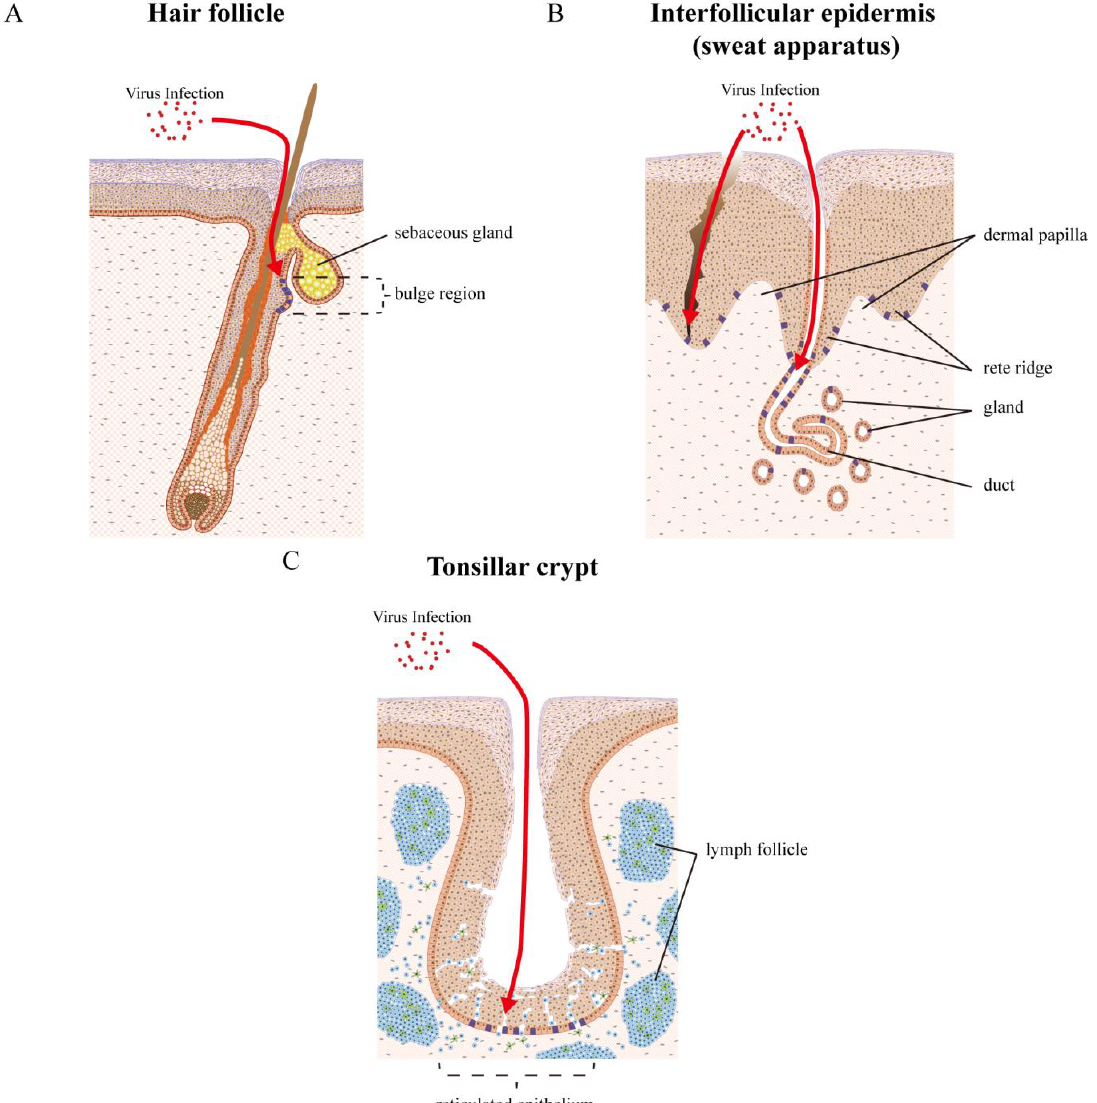
Figure 6. Epithelial tissue sites and tissue stem cells as targets for HPV infection.